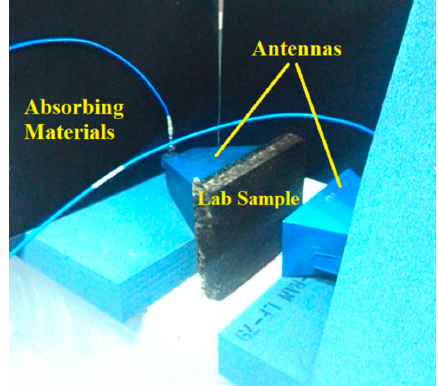
Figure 7. The testing system for the dielectric constant of lab samples. Table 1. The parameters and measured dielectric constants of lab samples.